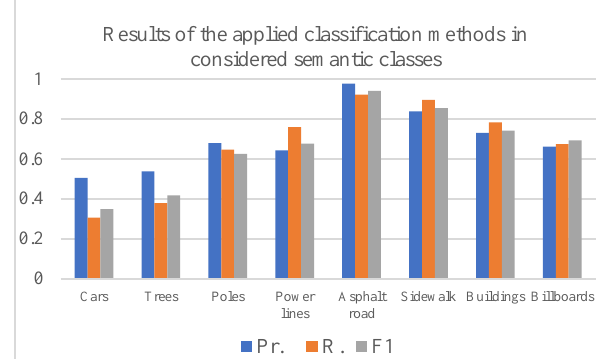
Figure 3. Evaluation of the applied classification algorithms for MTLS point cloud classification in urban area.